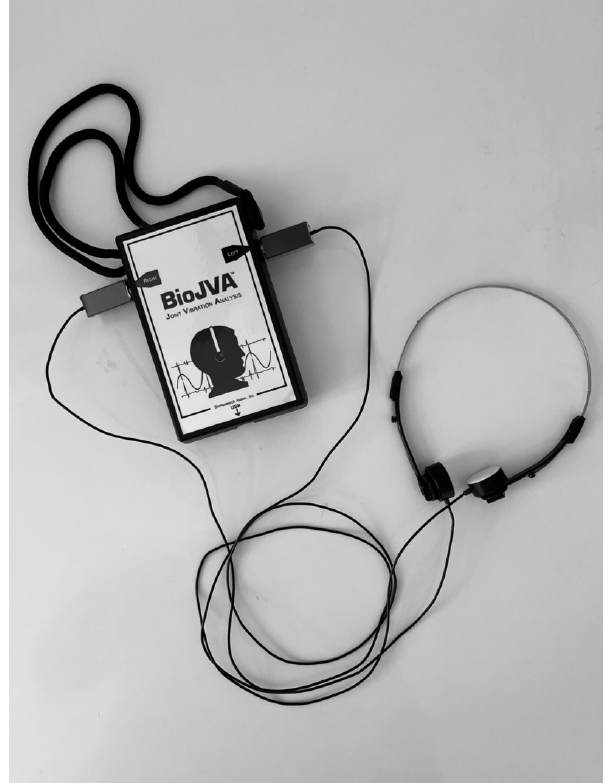
Figure 1. BioJVA Device (BioResearch, Inc., Milwaukee, WI, USA).